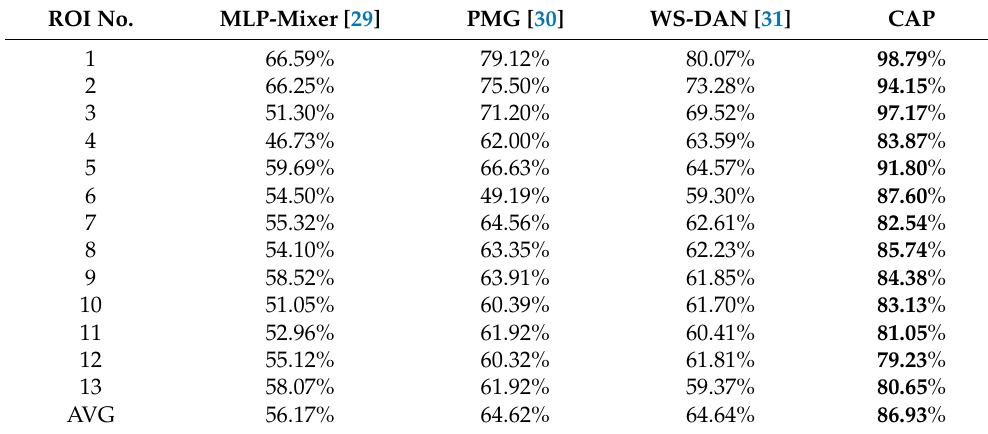
Table 1. Accuracy comparisons of different classification models on the clinical dataset. ROI